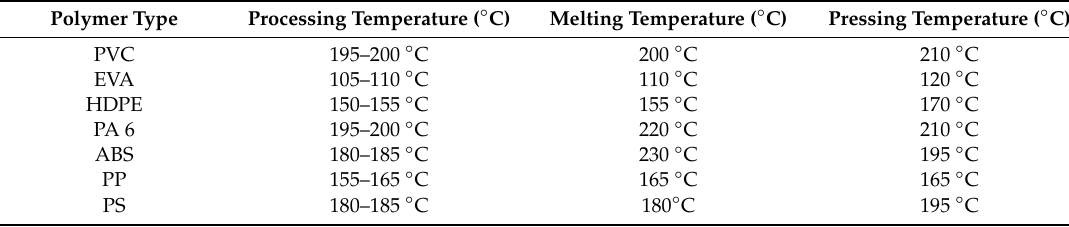
Table 2. Processing data of the 7 thermoplastics